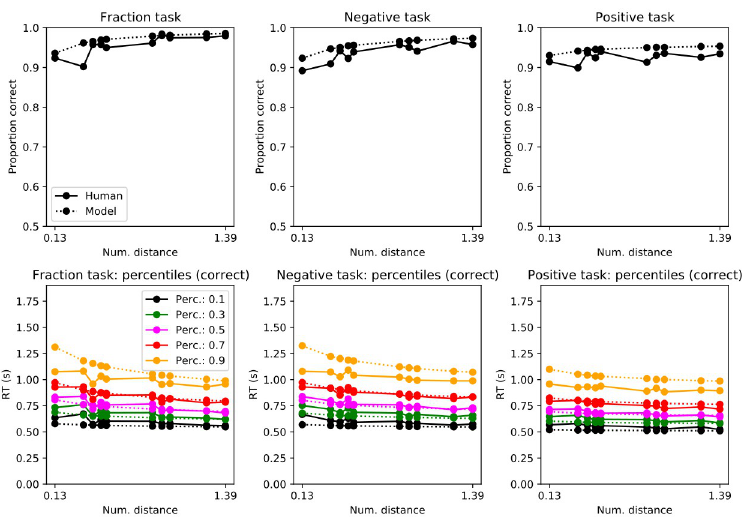
Fig 3. Accuracy (top) and response time distributions by percentiles (bottom) by trial type (Exp 1.). Numerical distance in log. scale. Response times are for correct trials; see Supplemental Information for incorrect trials.